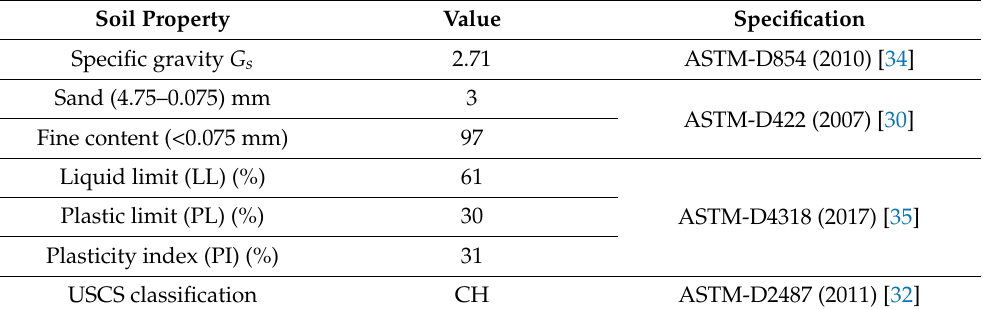
Table 2. Physical properties of